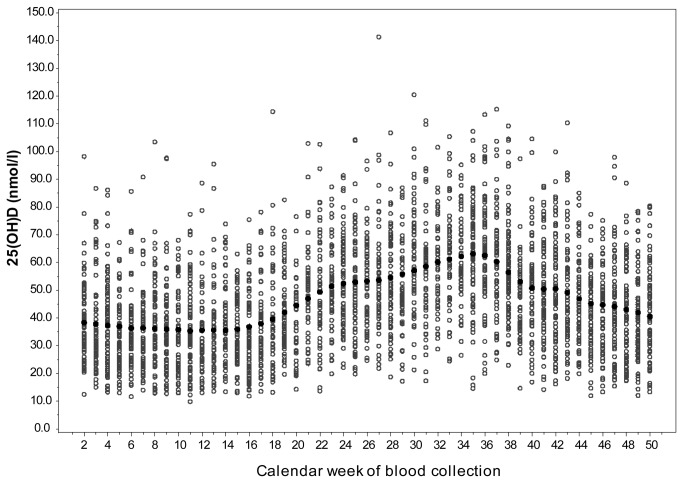
Seasonal variation in plasma 25(OH)D levels.The light circles represent individual 25(OH)D plasma concentrations, the black circles represent weekly average 25(OH)D plasma concentrations after smoothing by locally weighted polynomial regression.